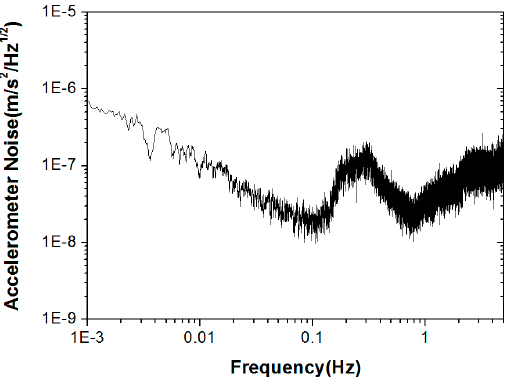
Figure 8. Acceleration measurement level using high-voltage-levitation scheme.